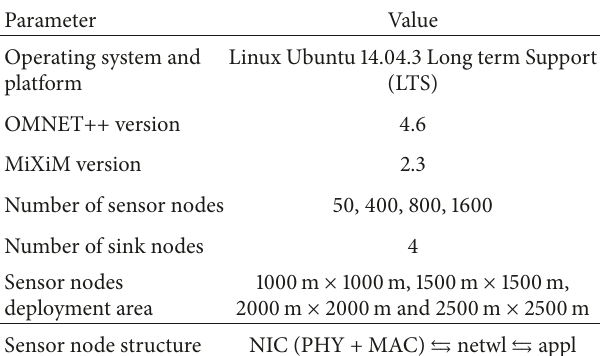
Table 3: MiXiM OMNET++ simulation parameters.